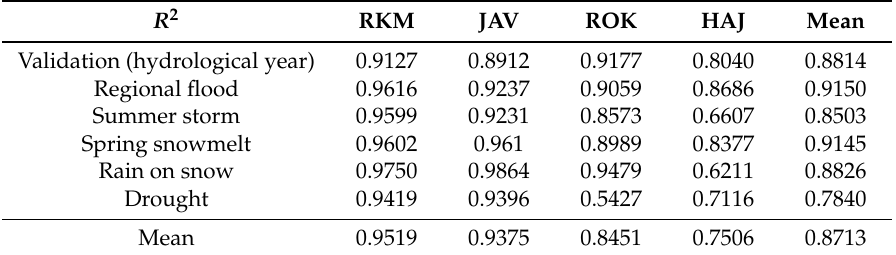
Rain on snow 0.9750 Drought 0.9419